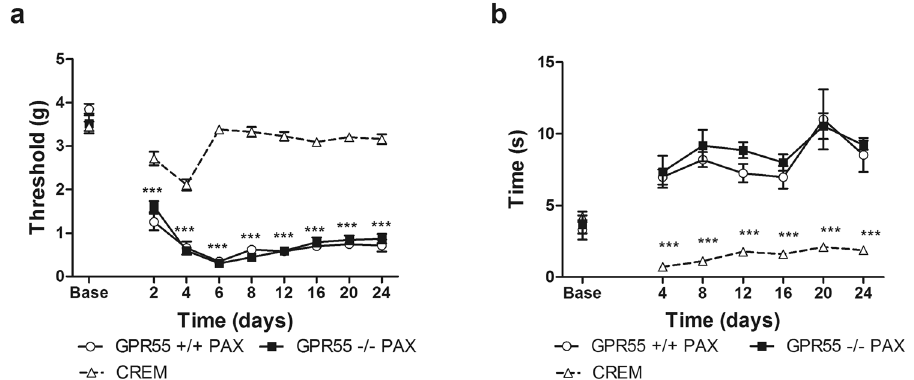
Figure 6. GPR55 KO and WT mice develop similar levels of paclitaxel-induced mechanical and cold allodynia. GPR55 KO and WT mice display similar levels of paclitaxel-induced mechanical ( a ) and cold ( b ) allodynia. Responding did not differ in GPR55 KO or WT mice that received the cremophor vehicle (CREM) in lieu of paclitaxel, and these groups were pooled into a single control (paclitaxel-untreated) group. Data are expressed as mean ± SEM (n = 5–8 per group). *** p < 0.001 GPR55 KO PAX and WT PAX vs. cremophor, 2-way ANOVA, Bonferroni